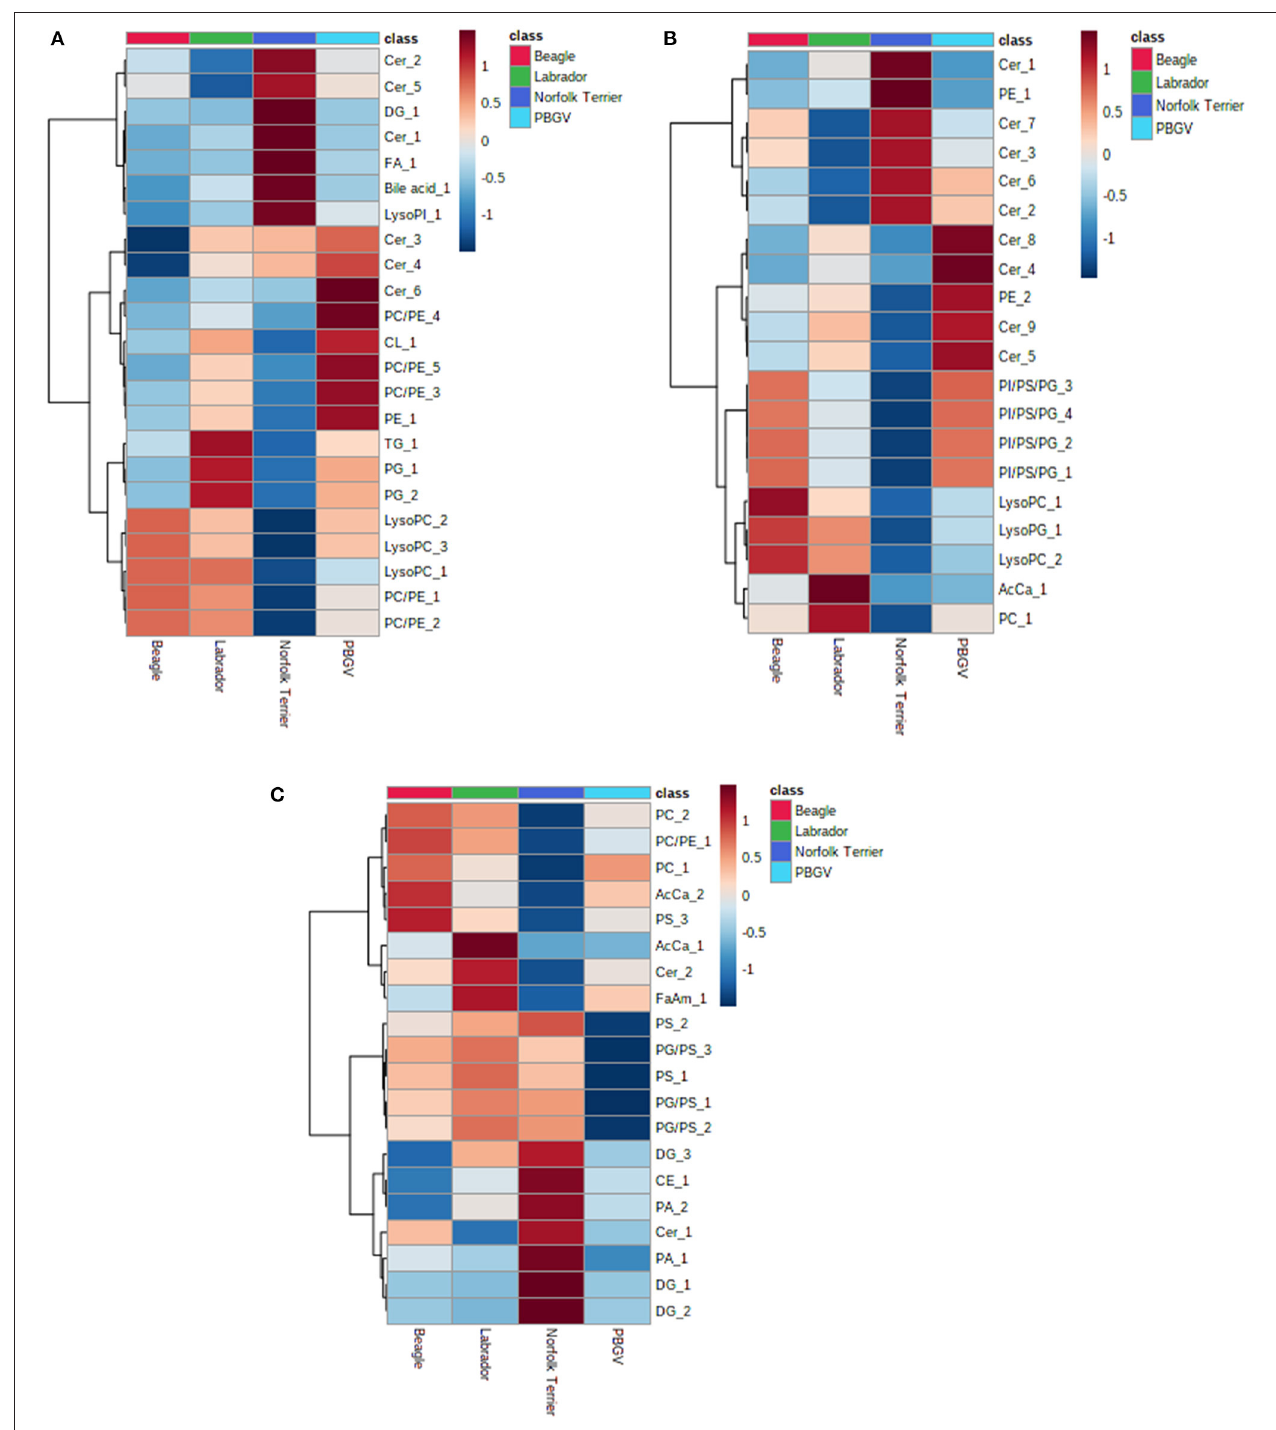
FIGURE 3 | Heatmap visualization of a small data set showing breed discriminatory ability collected using the lipid positive assay for (A) 20 µ L DBS samples, (B) 40 µ L DBS samples, and (C) 40 µ L plasma samples. Each breed average is colored differently (Beagle, red; Labrador retriever, green; Norfolk Terrier, dark blue; Petit Basset Griffon Vendeen, light blue). Each heatmap defines a small number of metabolites, and the breed with darkest red indicates the highest relative concentrations, darkest blue indicates the lowest concentrations, and the spectrum of blue and red in between represents intermediate concentrations. AcCa, acyl carnitine; Cer, ceramide; DG, diacylglyceride; FA, fatty acid; LysoPC, lysoglycerophosphocholine; LysoPG, lysoglycerophosphoglycerol; PA, phosphatidic acid; PC, glycerophosphocholine; PE, glycerophosphoethanolamine; PG, glycerophosphoglycerol; PI, glycerophosphoinositol; PS, glycerophosphoserine; TG, triacylglyceride.